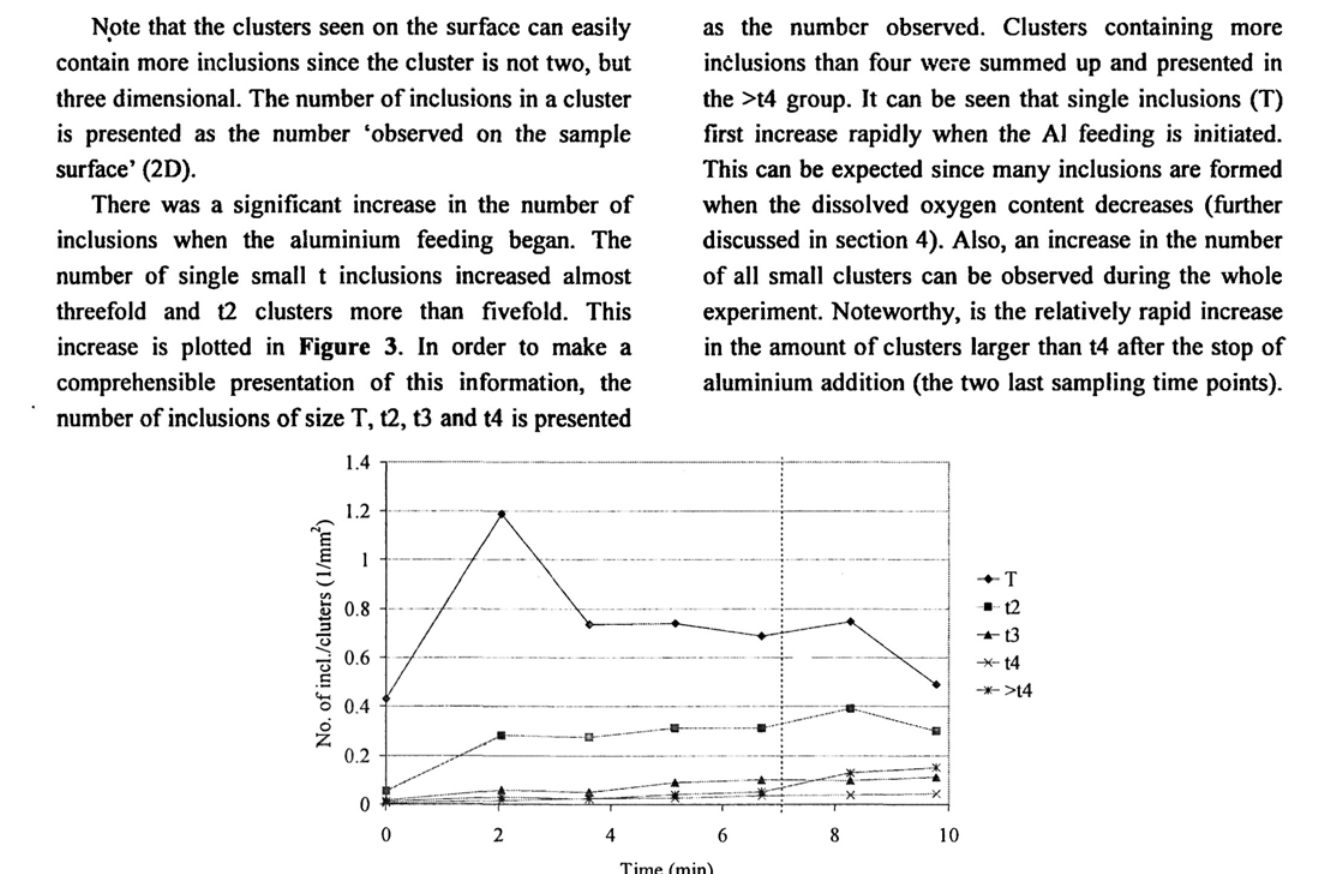
Here, it is important to note that the diameter of a cluster influences the likelihood of it being observed on the sample surface. This relationship between number of inclusions of a certain size in the steel volume N , and v the number visible on the surface N , can be better A understood by studying Equation l /16/, where the diameter is taken to be the external diameter of the cluster, D,, i.e. the diameter of a sphere that surrounds the whole cluster. If the number of clusters in two size groups increase and the relation between them per unit volume stays the same, the number of clusters in the surface will increase for the larger sized as the quotient between the diameters of the clusters in the larger and the smaller size